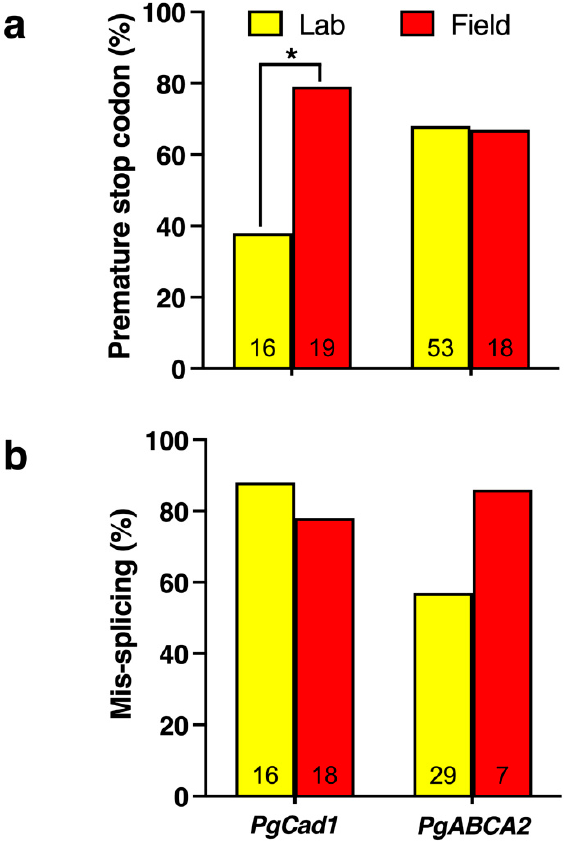
Figure 4. Percentage of mutations associated with pink bollworm resistance to Bt toxins involving ( a ) premature stop codons or ( b ) mis-splicing of pre-mRNA. Results from field-selected populations from India (red) or lab-selected strains (yellow) from the U.S. and China (PgCad1/Cry1Ac resistance) or only from the U.S. ( PgABCA2 /Cry2Ab resistance). The asterisks indicate a significant difference between lab- and field-selected pink bollworm in the percentage of PgCad1 mutations that involve a premature stop codon (Fisher’s exact test, p = 0.02). No significant difference between lab- and field-selected pink bollworm occurs in the other three analogous pairwise comparisons shown (Fisher’s exact test, p > 0.20 in each comparison). The numbers at the bottom of each bar are the total number of mutations evaluated for that bar. Data from Tables S1 and S2.